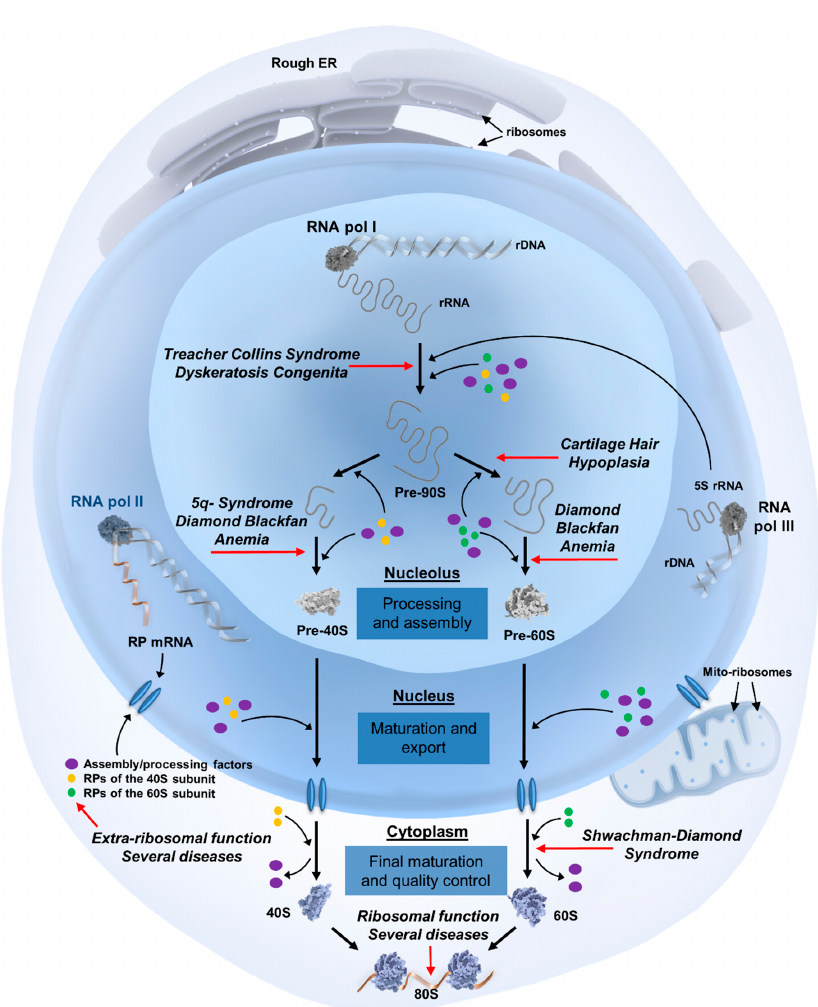
Figure 1. Overview of ribosome biogenesis and the steps affected in ribosomopathies. The eukaryotic ribosome assembly process begins in the nucleolus, a sub-compartment of the nucleus that is organized around ribosomal DNA (rDNA) transcription units. Three of the four main ribosomal RNA (rRNA) molecules are transcribed in the nucleolus as precursor rRNA by RNA polymerase I, with the last rRNA molecule being transcribed in the nucleoplasm by RNA polymerase III. These pre-rRNAs undergo extensive structural modifications before becoming the final 18S, 25S, 5.8S, and 5S rRNAs. Ribosomal protein mRNAs are transcribed by RNA polymerase II in the nucleoplasm, translated into proteins in the cytoplasm, after which they are transported back to the nucleolus to participate in additional processing steps. These steps comprise the formation of numerous assembly intermediates, including a